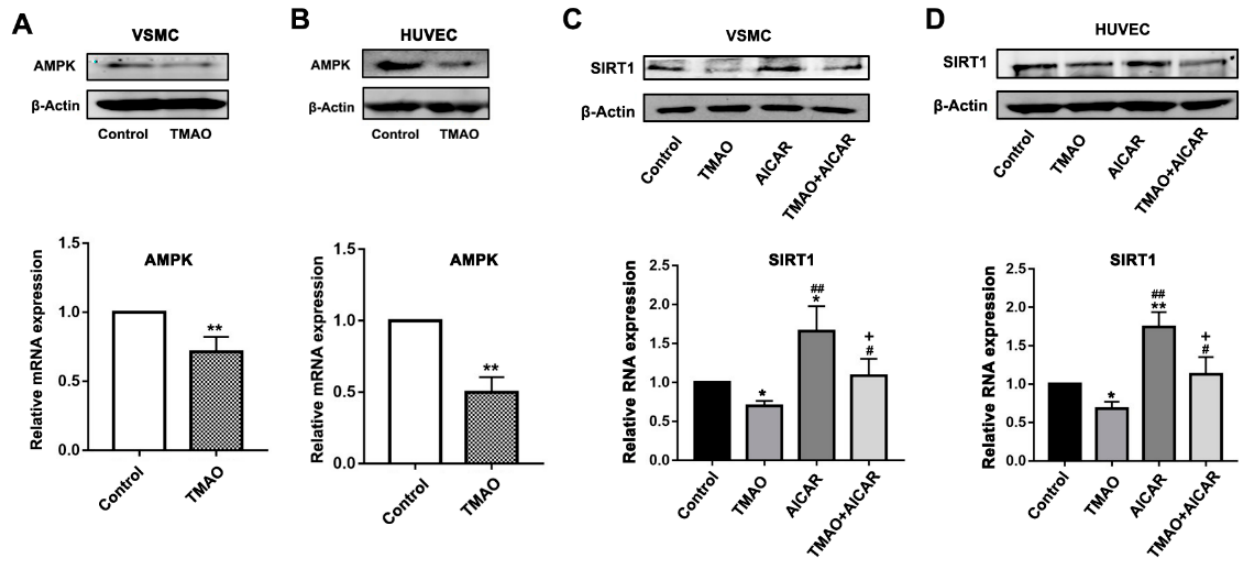
Figure 3. TMAO downregulates the SIRT1 level through AMPK in VSMCs and HUVECs. ( A , B ). The protein level (upper panels) and relative mRNA level (lower panels) of AMPK were detected after 1000 µ M TMAO treatment for 24 h by western blot and quantitative real-time PCR in VSMCs ( A ) and HUVECs ( B ). Values are the mean ± SD; n = 3, Student’s t -test. ** p < 0.01 vs. Control. ( C , D ) The protein level (upper panels) and relative mRNA level (lower panels) of SIRT1 was detected after 1000 µ M TMAO, 5 mM AICAR and 1000 µ M TMAO plus 5 mM AICAR treatment for 24 h by western blot and quantitative real-time PCR in VSMCs ( C ) and HUVECs ( D ). Values are the mean ± SD; n = 3; two-way ANOVA followed by a Tukey post hoc test. * p < 0.05; ** p < 0.01 vs. Control; # p < 0.05, ## p < 0.01 vs. TMAO group; + p < 0.05 vs. the AICAR group.